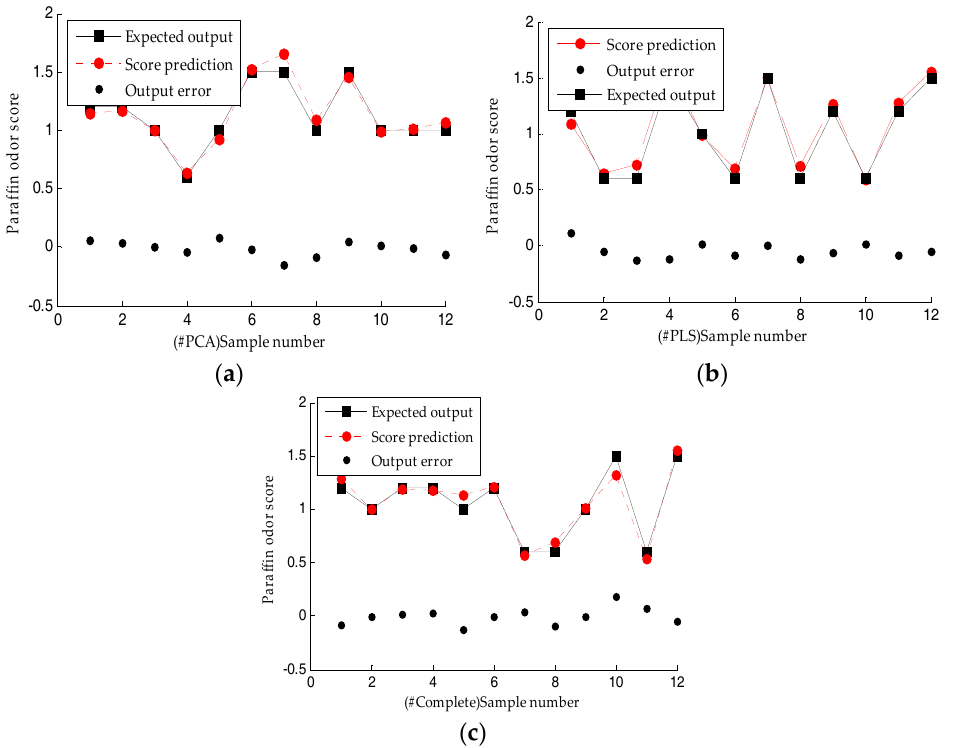
Figure 8. Score prediction of the paraffin odor based on the ELM model: ( a ) Based on the PCA-optimized feature set; ( b ) Based on the PLS-optimized feature set; ( c ) Based on the original feature set. Table 8. Prediction error of different paraffin odor levels based on RF.